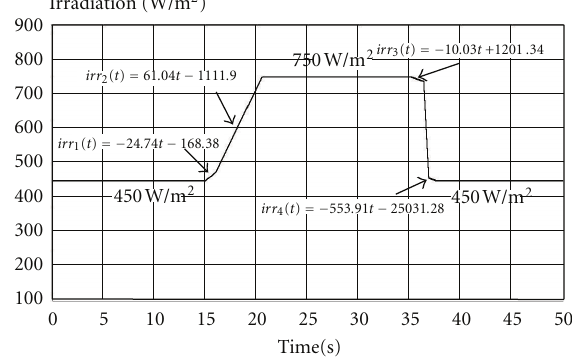
Figure 8: Simulation waveform of irradiation that increased from 450 W/m 2 to 750 W/m 2 and then dropped back to 450 W/m 2 .